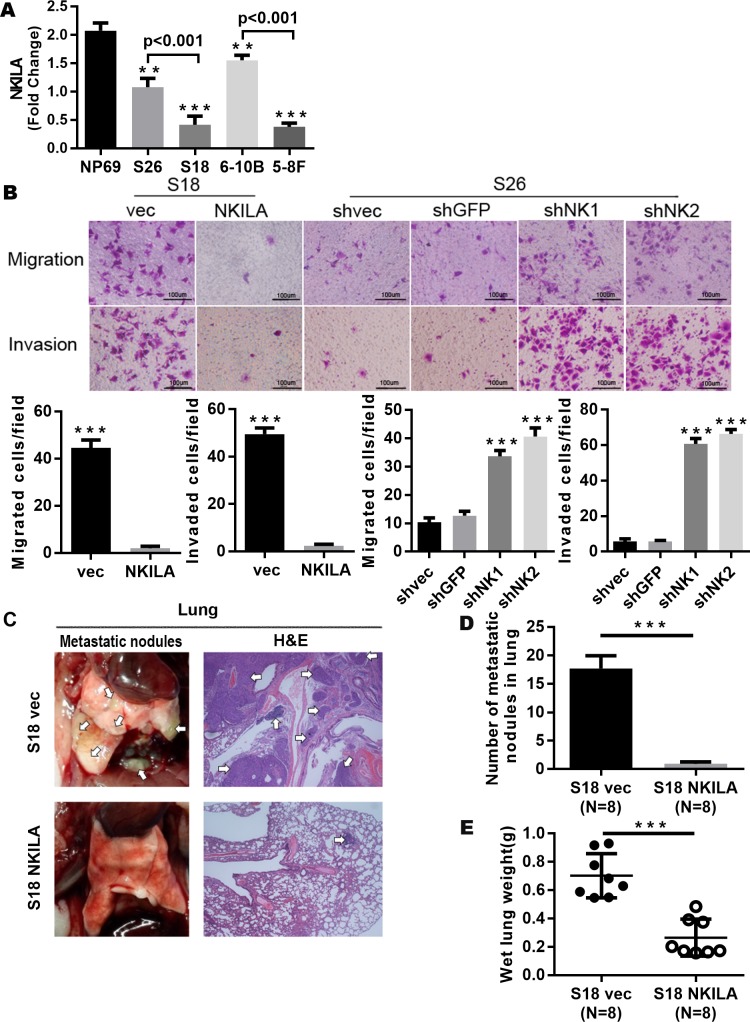
NKILA repress the metastasis of NPC by inhibiting the NF-kB pathway.(A) NKILA expression in NPC cell lines determined by qRT-PCR assay (Mean ± SD, n = 3, ***, P < 0.001, **, P < 0.01versus NP69). (B) Representative images of migrated and invaded NPC cells with overexpressed or silenced NKILA in Boyden chamber assay (Mean ± SD, n = 3, ***, P < 0.001, versus control). (C) Representative images of the lung metastasis, metastatic nodes were indicated by Arrowheads. Left: Representative lungs, Right: Representative image (×200) of lung with metastasis by H&E staining. (D) 6 weeks after tail vein injection, number of metastases in lungs of each mice (mean±SD) were calculated. (E) The wet lung weight of the mice treated with the control vehicle was significantly higher, suggesting that mouse in control group had more or greater metastases, indicating that NKILA inhibited tumor metastasis.